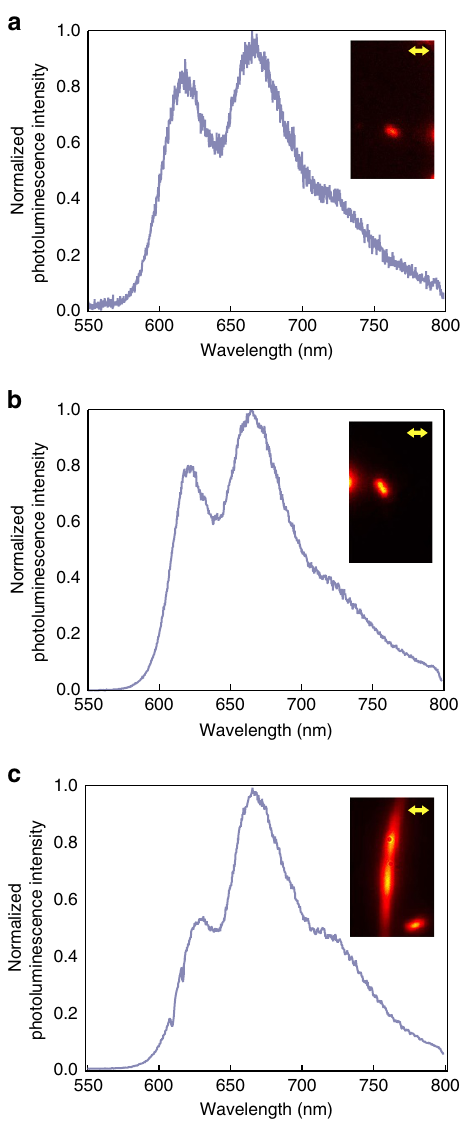
Figure 2 | PL spectral evolution with increased crystal aspect ratio. PL spectra of ( a ) a nanocrystallite with an AR approximately equal to 1, ( b ) a crystal with an AR 4 1 and o 3 and ( c ) a nanowire with an AR Z 3 with corresponding PL images, Scale bar, 300nm. Note the qualitative changes in PL spectra indicating the structural envelope.